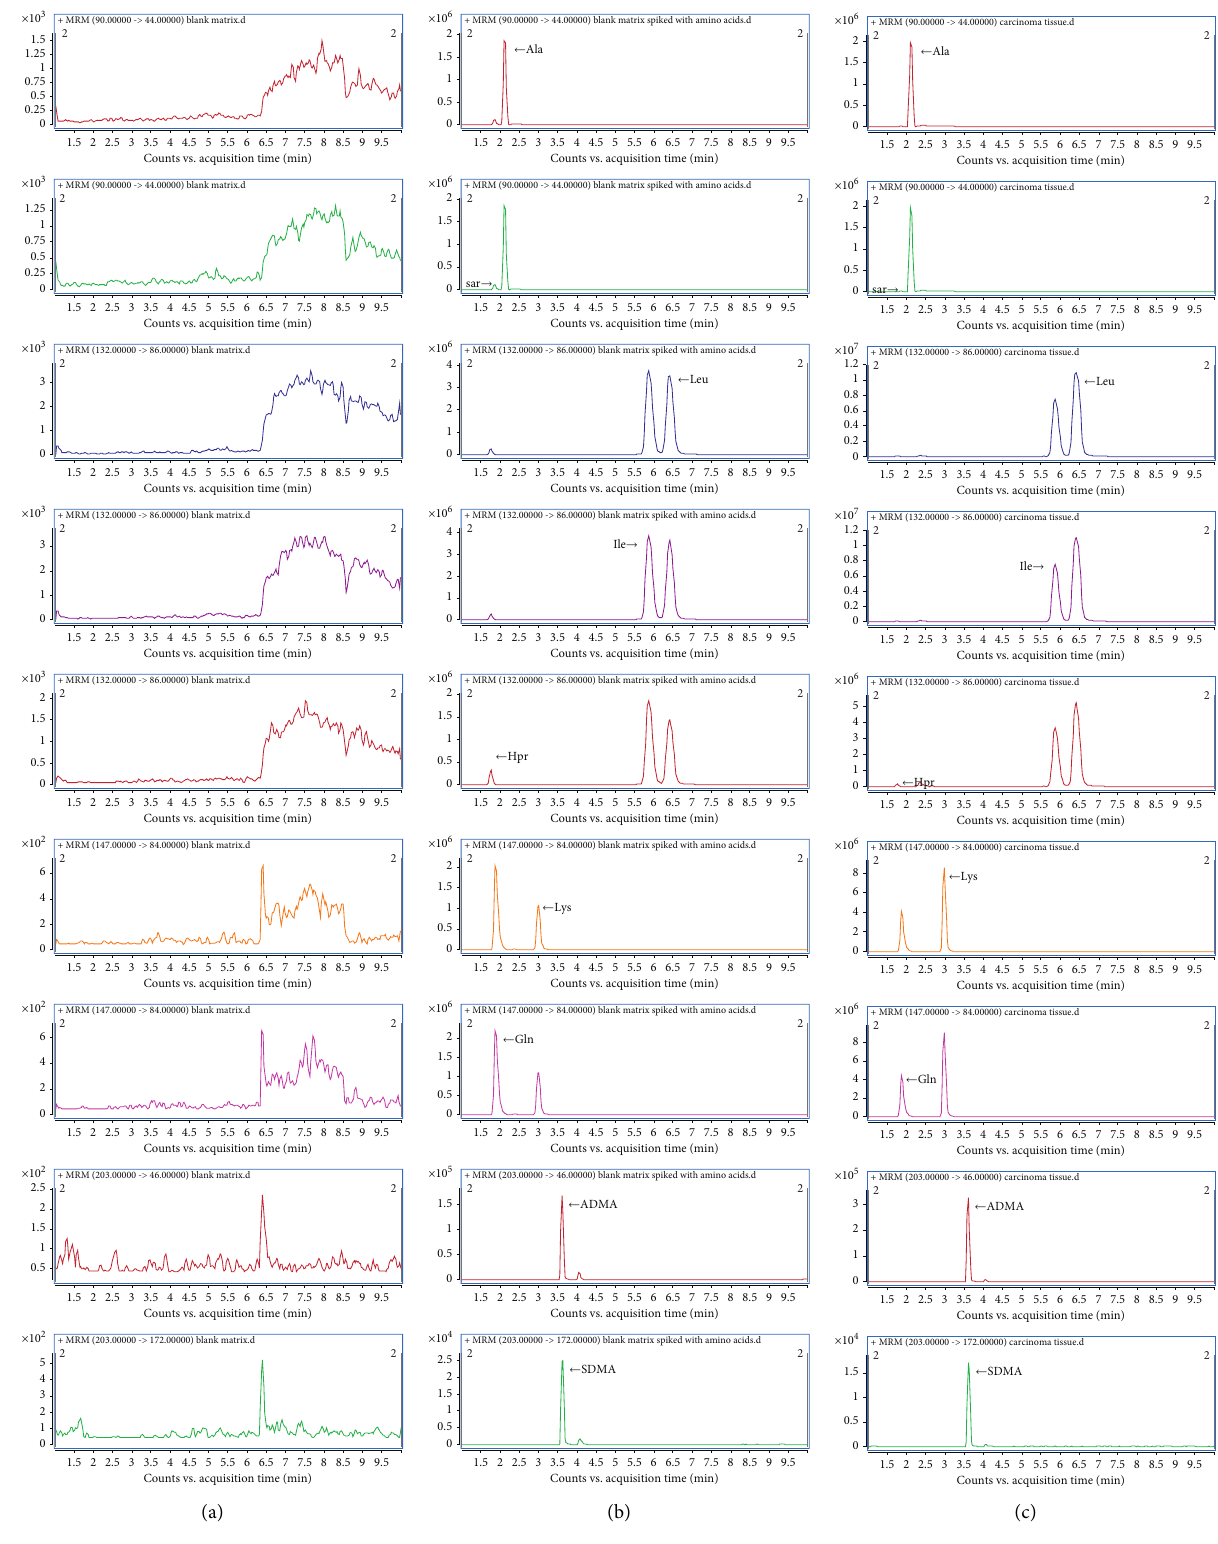
Figure 2: The representative MRM chromatograms of Ala, Sar, Leu, Ile, Hpr, Lys, Gln, ADMA, and SDMA: (a) blank matrix; (b) blank matrix spiked with 34 amino acid and 3 ISs; (c) cancerous tissue